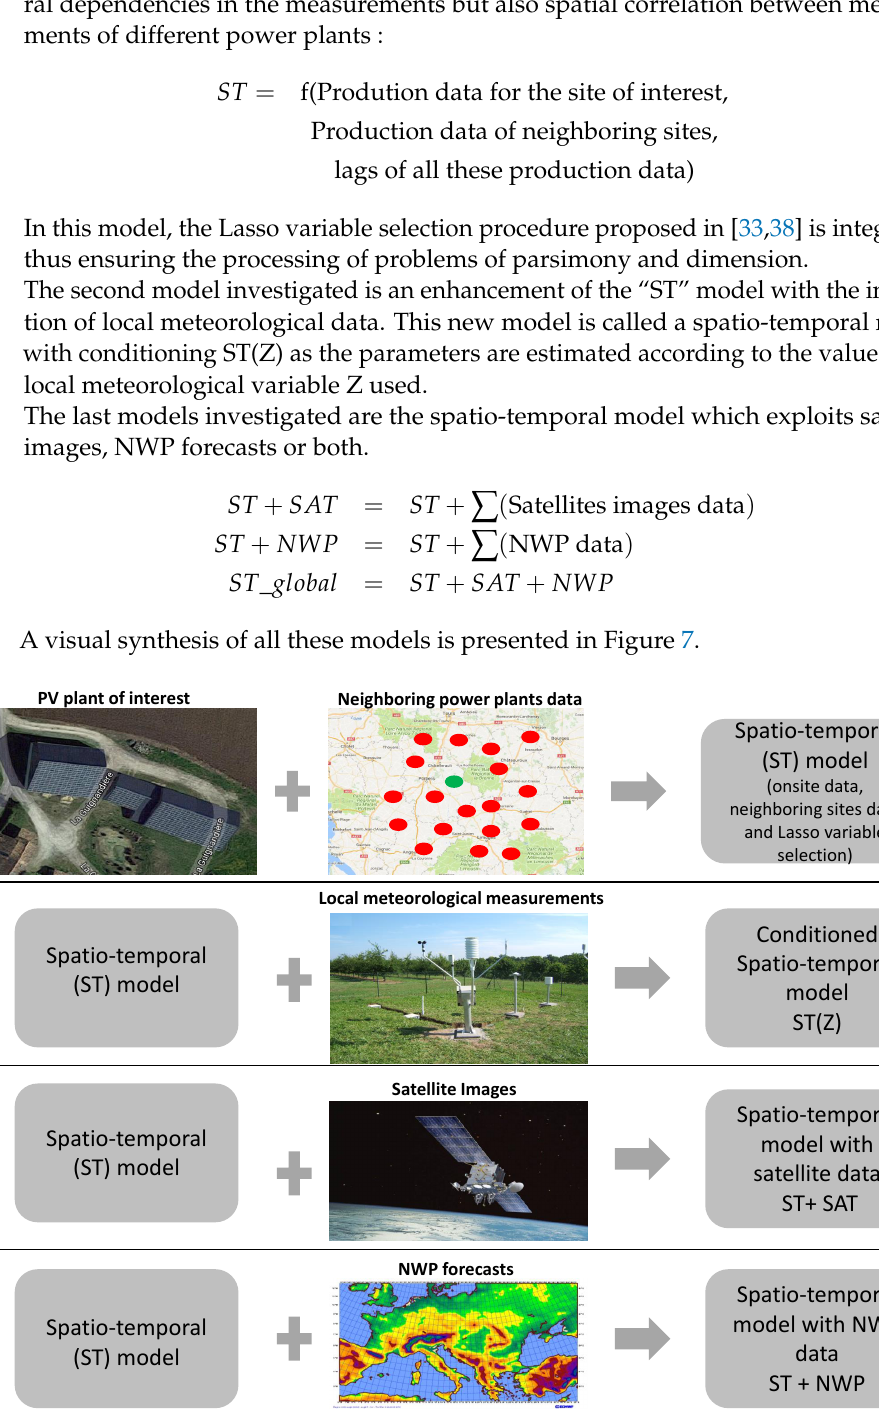
Figure 7. The different models implemented for the comparison of data